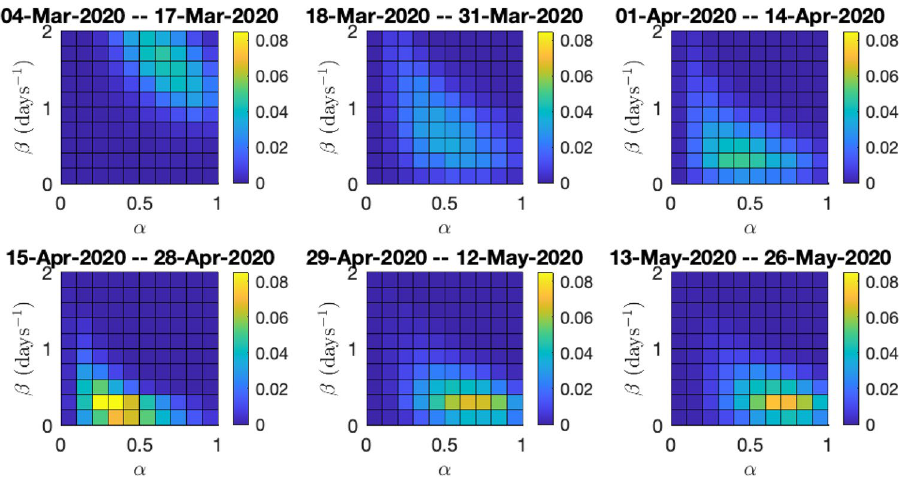
Figure 7. Joint posterior distributions of the reporting rate α and the transmission rate β in Model 1, for the six fortnight periods starting from 04/03/2020 until 26/05/2020. Analysis using the full data.